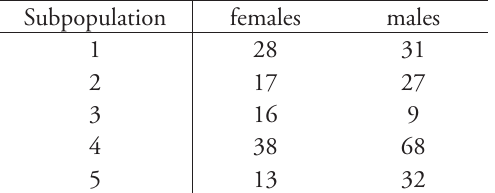
Table 2. The numbers of adult Norwegian red deer with known sex which were sampled in each of five identified subpopulations.